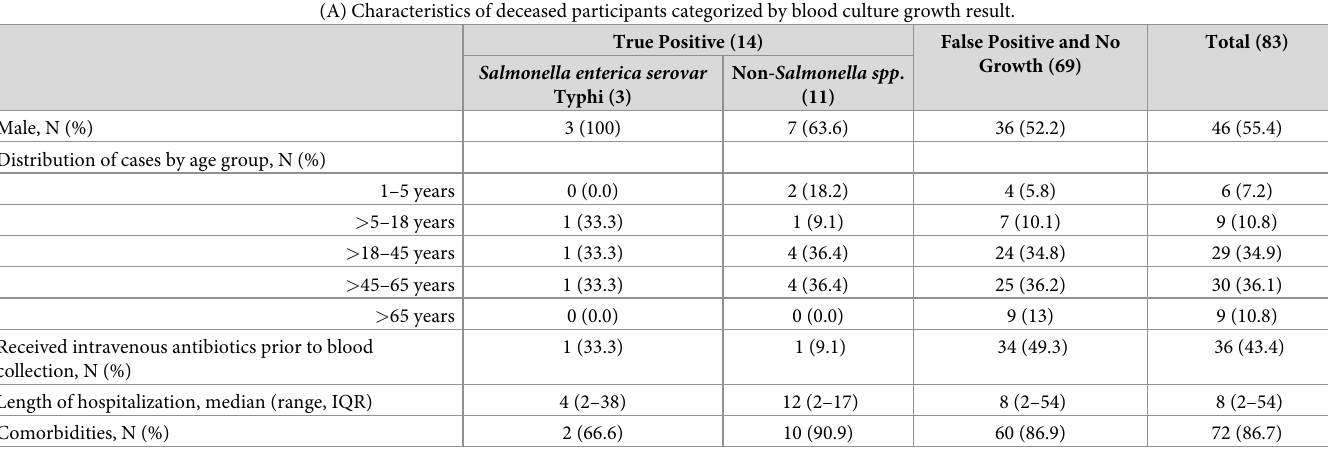
Table 5. Participant characteristics, clinical diagnoses, and identified pathogens from fatal cases in the study. (A) Characteristics of deceased participants categorized by blood culture growth